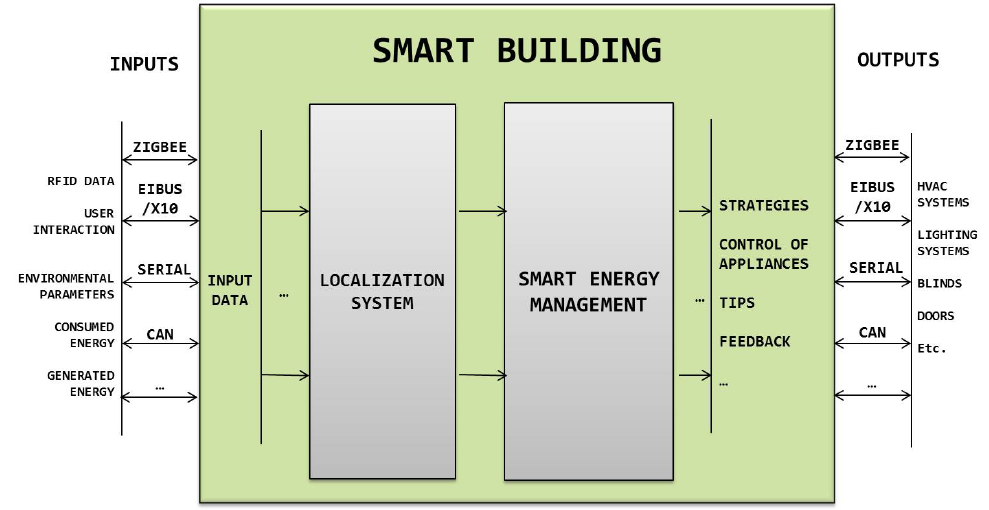
Figure 4. Our Energy Management Platform for buildings.